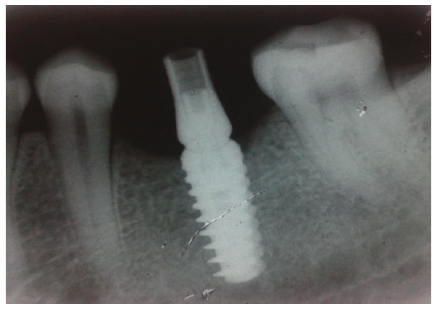
Figure 10: Cementation of crown.